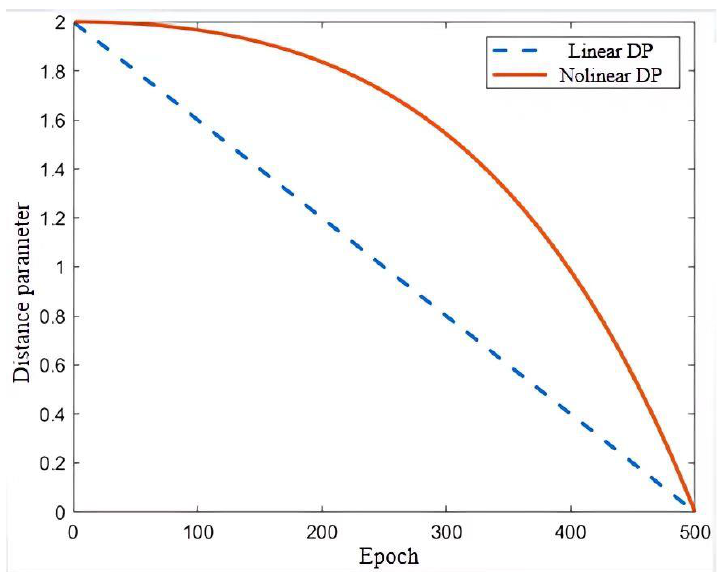
Figure 9. Nonlinear distance parameters and linear distance parameters comparative analysis.